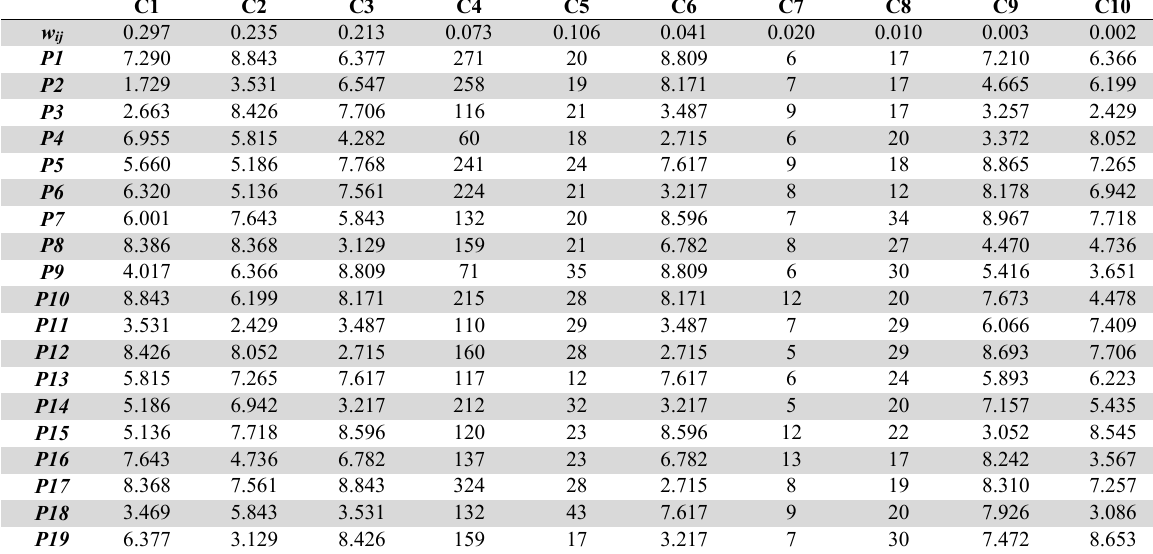
The initial decision matrix of the VIKOR